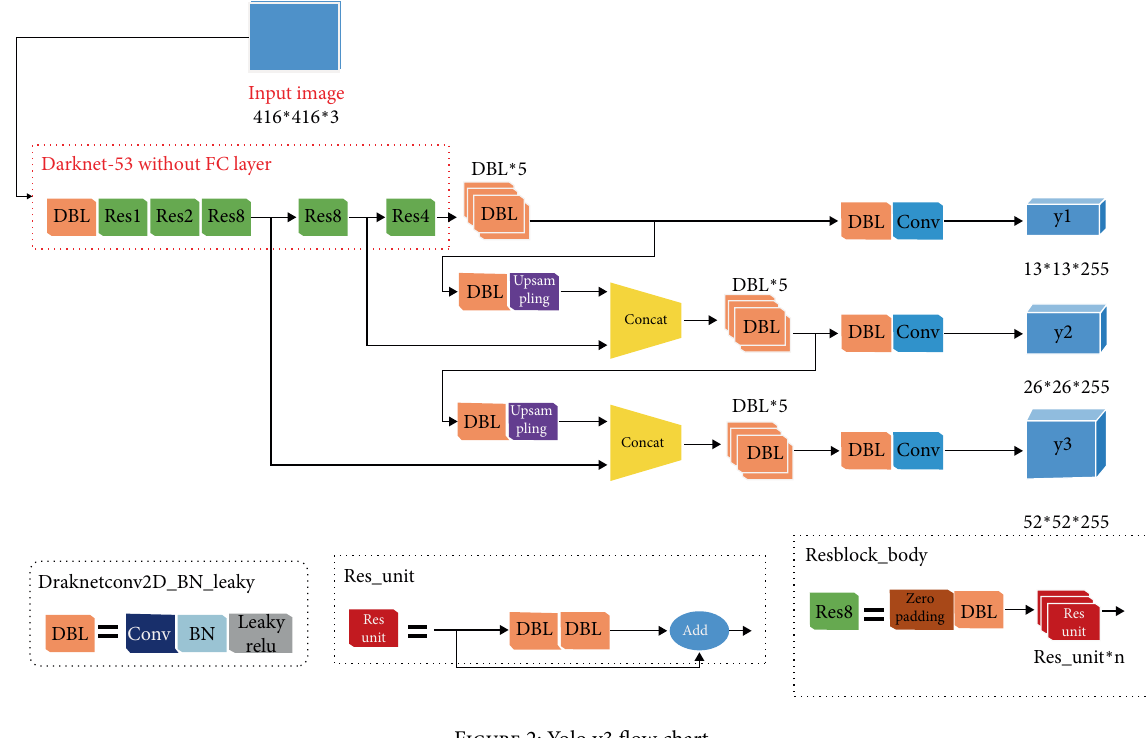
Figure 2: Yolo v3 flow